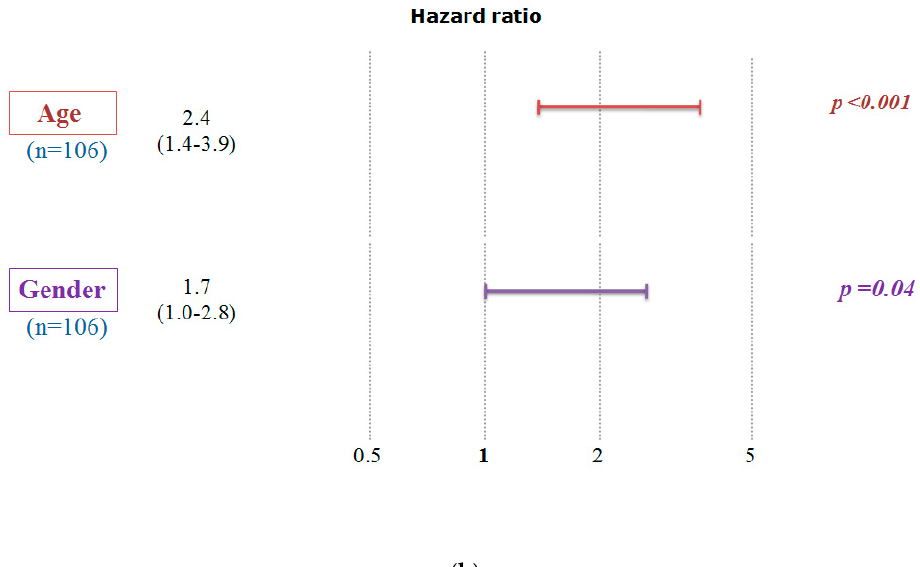
Figure 2. Multivariate Cox analysis demonstrates that the poor survival of CGGA patients ac- cording to A 2A R expression level is influenced only by gender. A hazard ratio (HR) value greater than 1 indicates that high gene expression gives a poor prognosis. ( a ) Low A 2A R expression and ( b ) High A 2A R expression. (Codes: Age < 44 years: 0; Age > 44 years: 1; Women: 0; Men: 1).